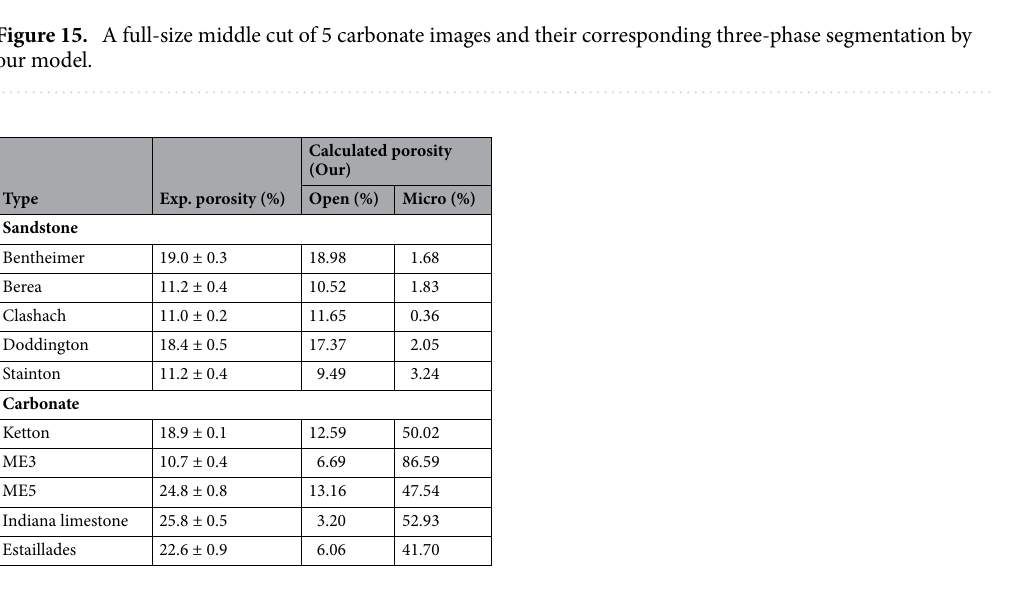
Table 5. Comparison between experimental and our model segmentation porosity for several sandstone and carbonate micro-CT-images.